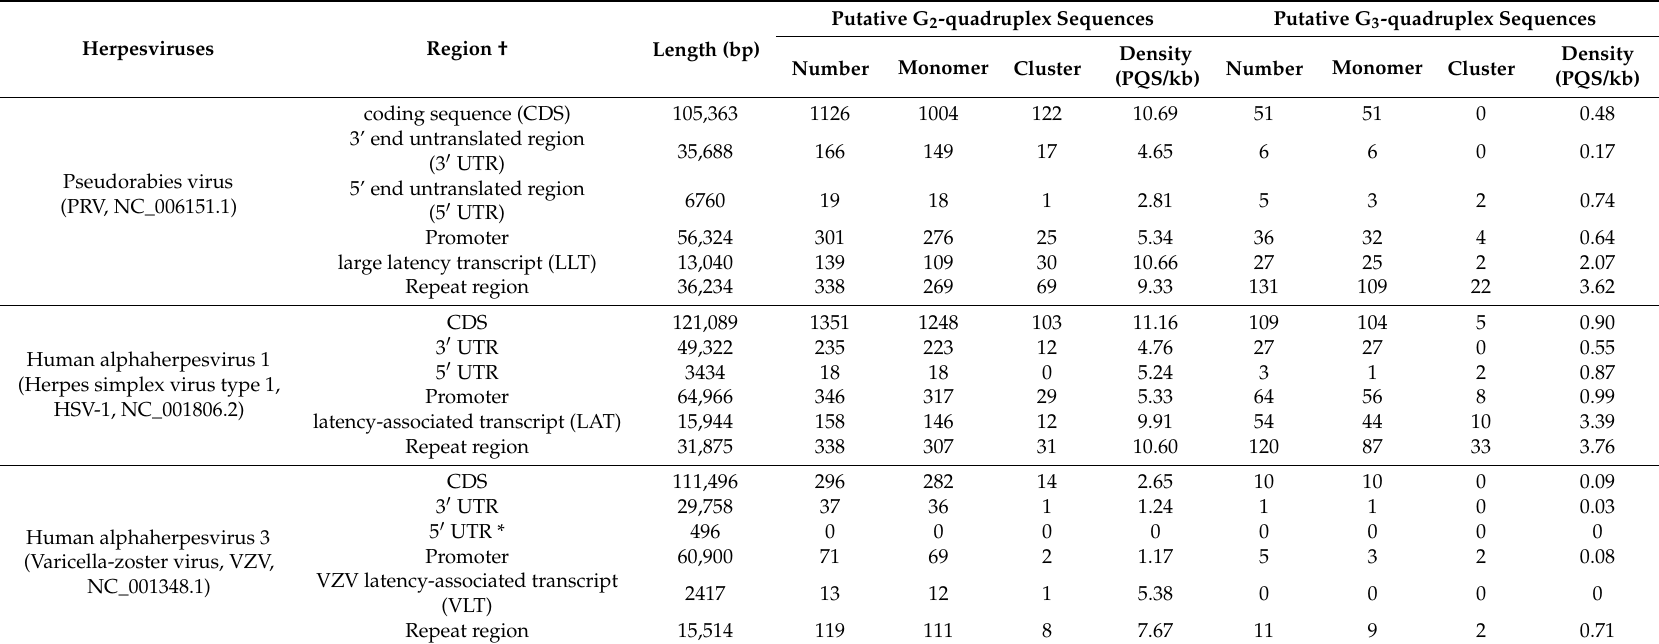
Putative G 2 -quadruplex Sequences